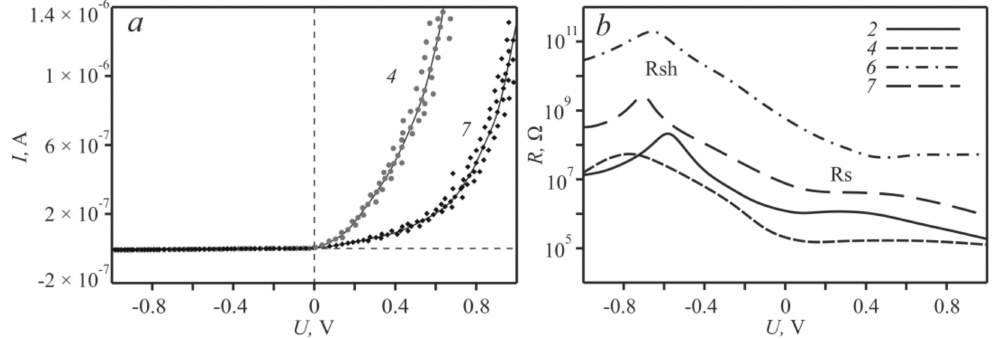
Figure 4. Current–voltage characteristics ( a ); and the dependence of the resistance on the bias voltage of the / Al / Zncomplex / ITO structure ( b